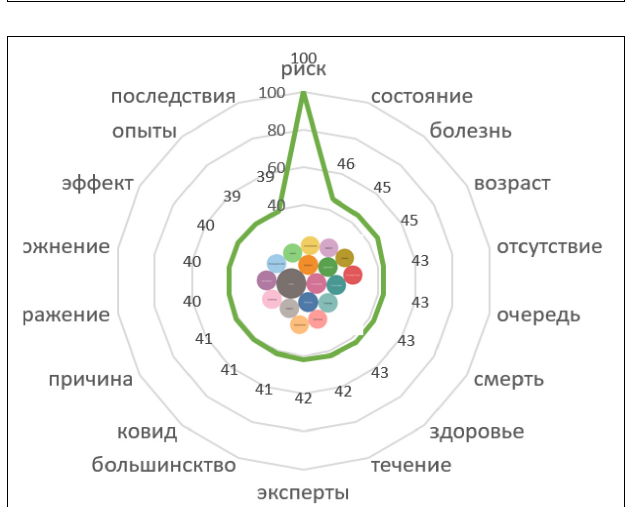
FIGURE 8 | Associative network of the stimulus Sputnik.